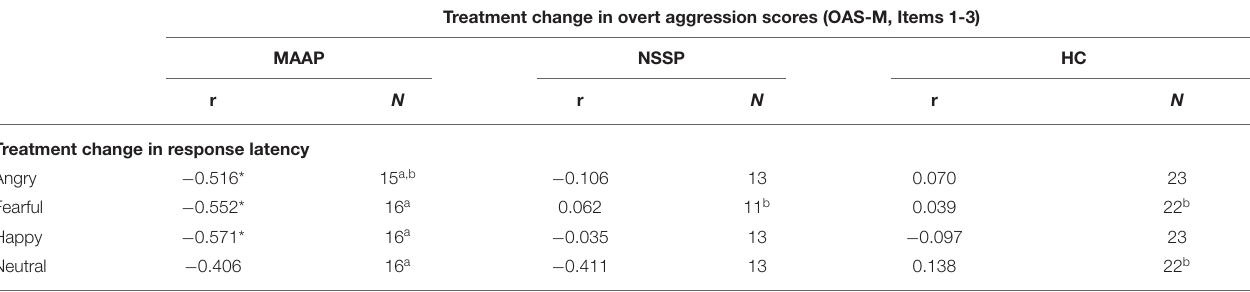
TABLE 3 | Correlational analyses between treatment change in variables measured in the emotion classification task and overt aggression measured with the OAS-M. Treatment change in overt aggression scores (OAS-M, Items 1-3) MAAP NSSP HC r N r N r N Treatment change in response latency Angry